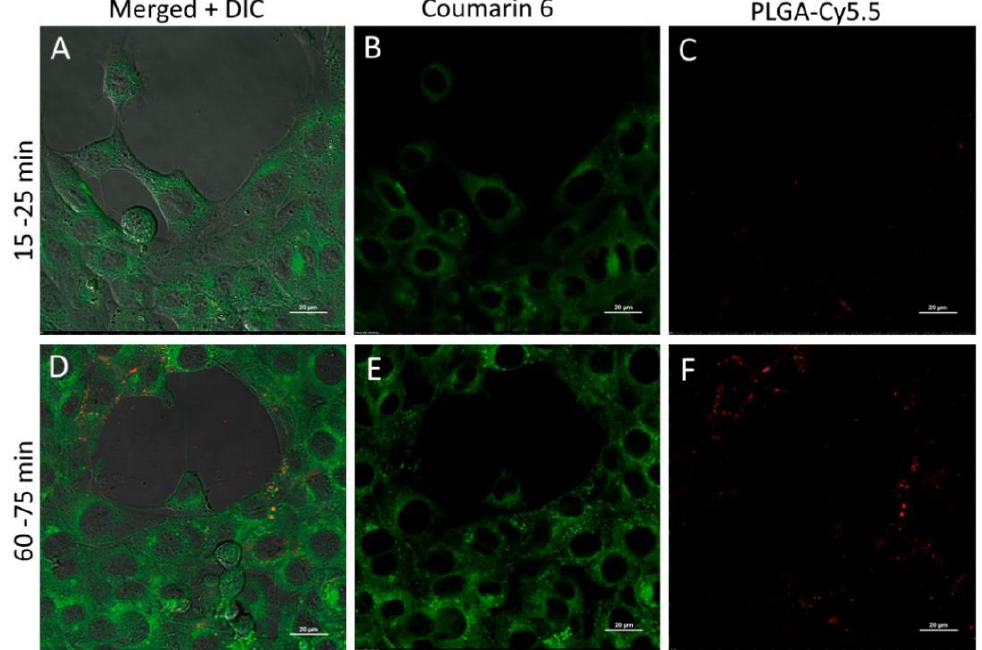
Figure 9. Internalization of PLGA-Cy5.5/Cou6 nanoparticles into 4T1 cells after 15–25 min ( A – C ) or 60–75 min ( D – F ) incubation (laser scanning confocal microscopy, Nikon A1 NP). ( A , D )—merged image and differential interference contrast (DIC); ( B , E )—coumarin 6 fluorescence; ( C , F )—PLGA-Cy5.5 fluorescence. Scale bar 20 μm.